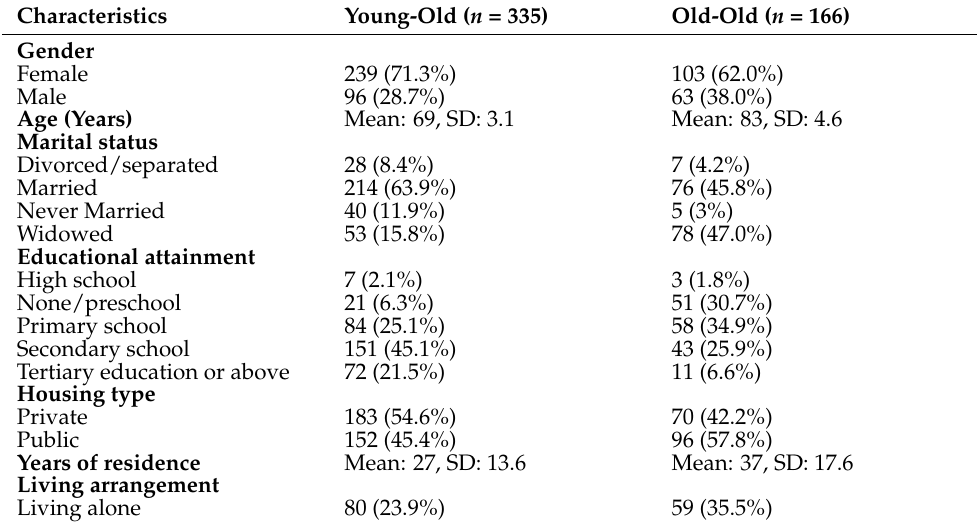
Table 1. Participants’ Sociodemographic